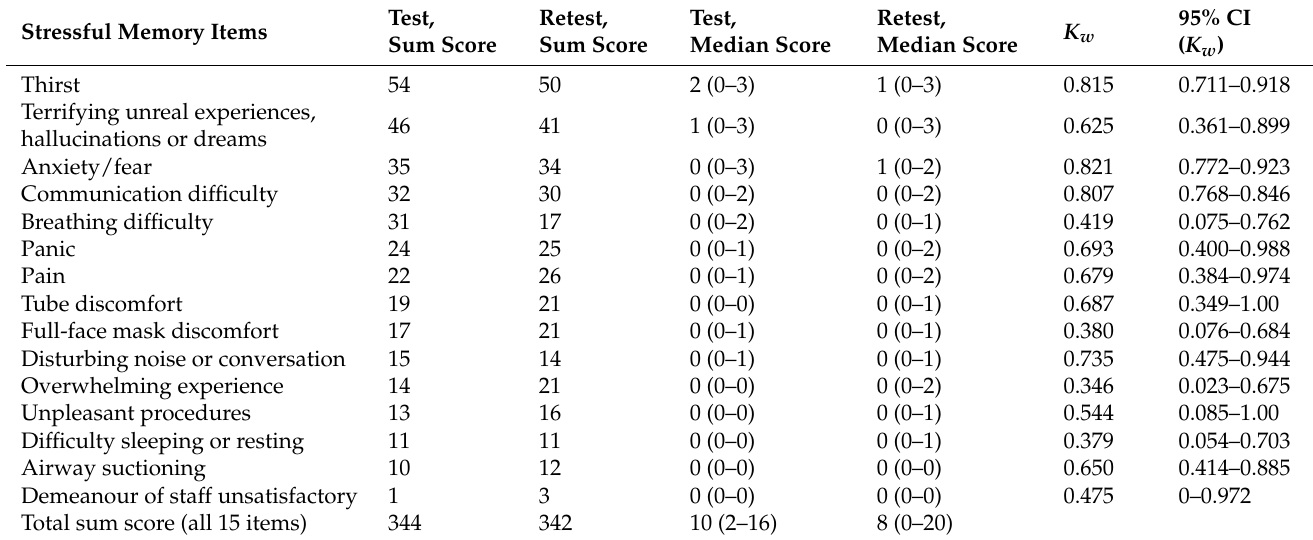
Table 3. Test and retest scores of stressful memory items and corresponding weighted kappa values ( K w ) in intensive care survivors (N =